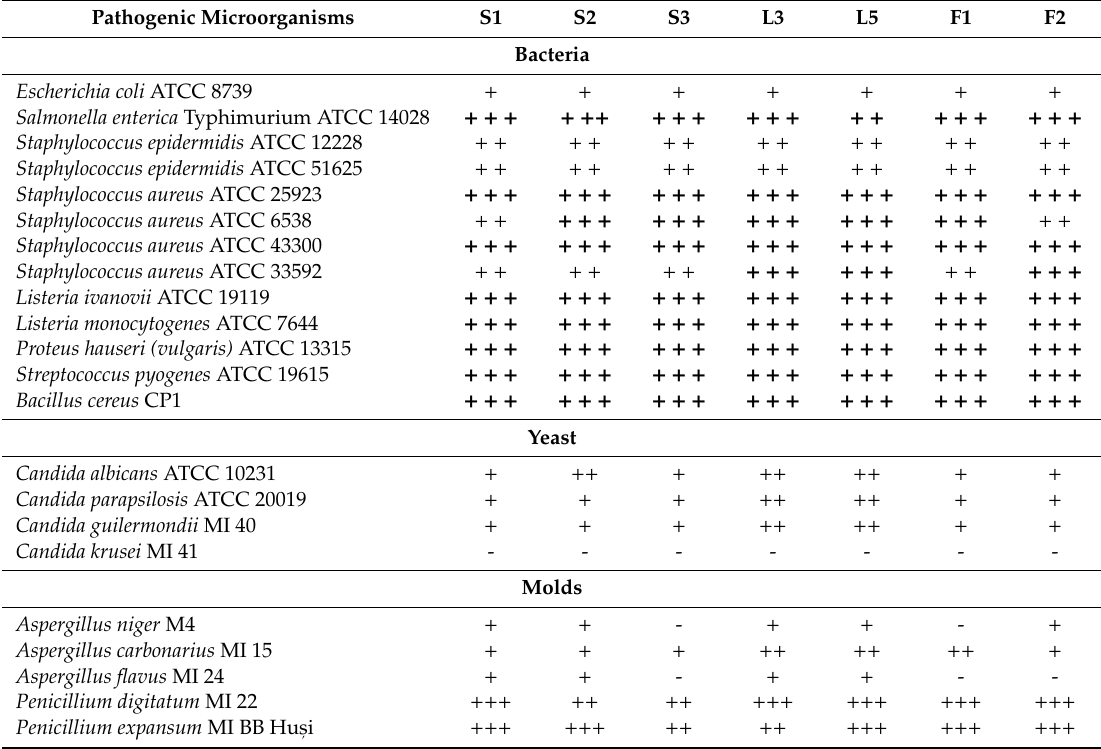
Table 2. Inhibitory activity of Kombucha LAB isolates on pathogenic microorganisms were tested using an adapted disk di ff usion